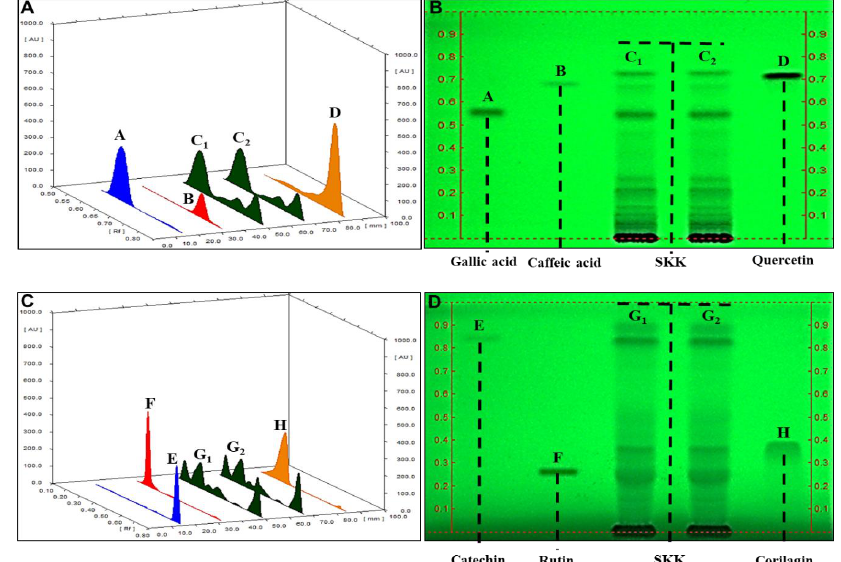
Figure 1. Chromatograms of Sarva-Kalp-Kwath (SKK) extract in the High Performance Thin Layer Chromatography (HPTLC) analysis. Chemical constituent analysis of SKK using HPTLC showed ( A ) comparative fingerprint analysis at 280 nm of (C 1 , C 2 ) SKK with (A) gallic acid, (B) ca ff eic acid, and (D) quercetin markers. ( B ) Corresponding comparative HPTLC image at 254 nm of (C 1 , C 2 ) SKK with (A) gallic acid, (B) ca ff eic acid, and (D) quercetin markers. ( C ) Comparative fingerprint at 280 nm of (G 1 , G 2 ) SKK with (E) catechin, (F) rutin, and (H) corilagin markers. ( D ) Corresponding comparative HPTLC image at 254 nm of (G 1 , G 2 ) SKK with (E) catechin, (F) rutin, and (H) corilagin markers. Results are displayed as 3D-overlaid spectra of SKK and marker compounds and their respective HPTLC